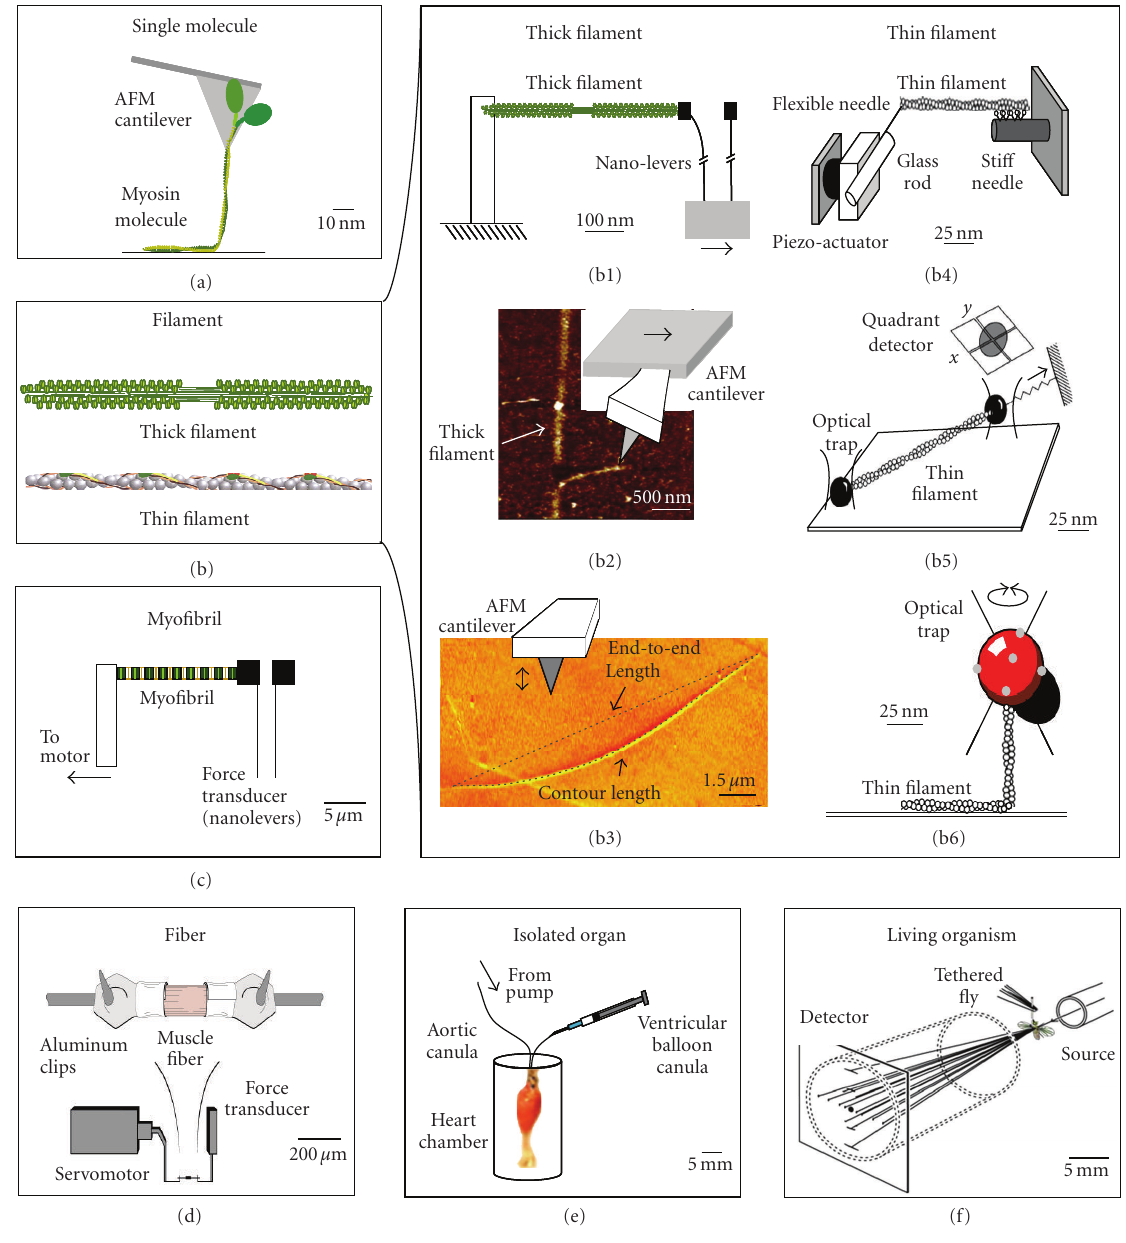
Figure 1: Some approaches used to measure the biomechanical properties of muscle, from single molecules to a living organism. Scale bars are approximate and are based on the size of the preparations, not the equipment. (a) Measurement of axial forces produced when pulling individual myosin molecules [2, 3] (figure adapted from [3]). (b) The biomechanical characteristics of thick filaments and thin filaments have been measured with a variety of techniques. (b1) Measurement of elastic properties of thick filaments with cantilevers [4, 5] (figure adapted from [5]). Thin filament elastic properties also have been measured in this way [6]. (b2) Shearing and bending of thick filaments with an AFM probe [7] (figure modified from [7]). (b3) Young’s modulus and persistence length of thick filaments calculated from AFM images [8, 9] (figure modified from [9]). The persistence length of thin filaments has also been measured by monitoring their thermal fluctuations in shape [10–12]. (b4) Axial sti ff ness of thin filaments measured with a glass microneedle [13] (figure adapted from [13]). (b5) Flexural rigidity of thin filaments measured in an optical trap [14] (figure modified from [14]). (b6) Torsional rigidity of thin filaments [15, 16] (figure adapted from [16]). (c) Axial passive sti ff ness of myofibrils measured with cantilever force transducers [17–19] (adapted from [17]). (d) Elastic and viscous properties of skinned muscle fibers [20–22]. (e) Elastance of the heart [23, 24]. The scale bar here reflects a mouse heart. (f) X-ray di ff raction of live Drosophila flight muscles